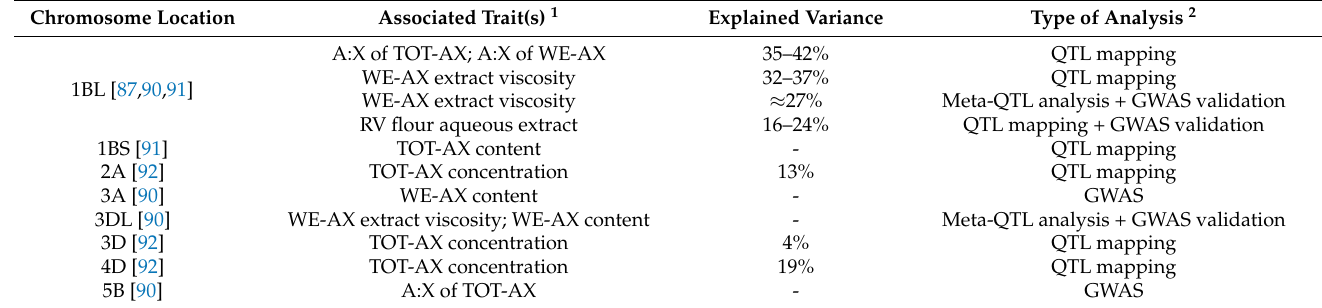
Table 3. List of arabinoxylan-related quantitative trait loci (QTLs) reported in wheat. The QTLs on chromosome 1BL, are proposed to coincide [90,91]. From the available literature it is unclear